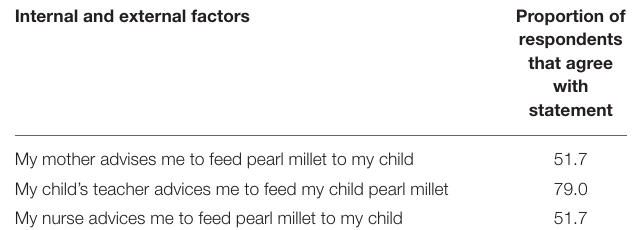
TABLE 3 | Internal and external factors influencing pearl millet